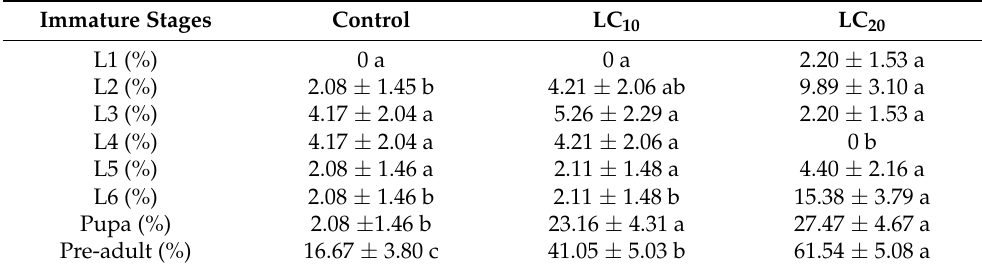
Table 4. Sublethal effects of EMB on FAW offspring